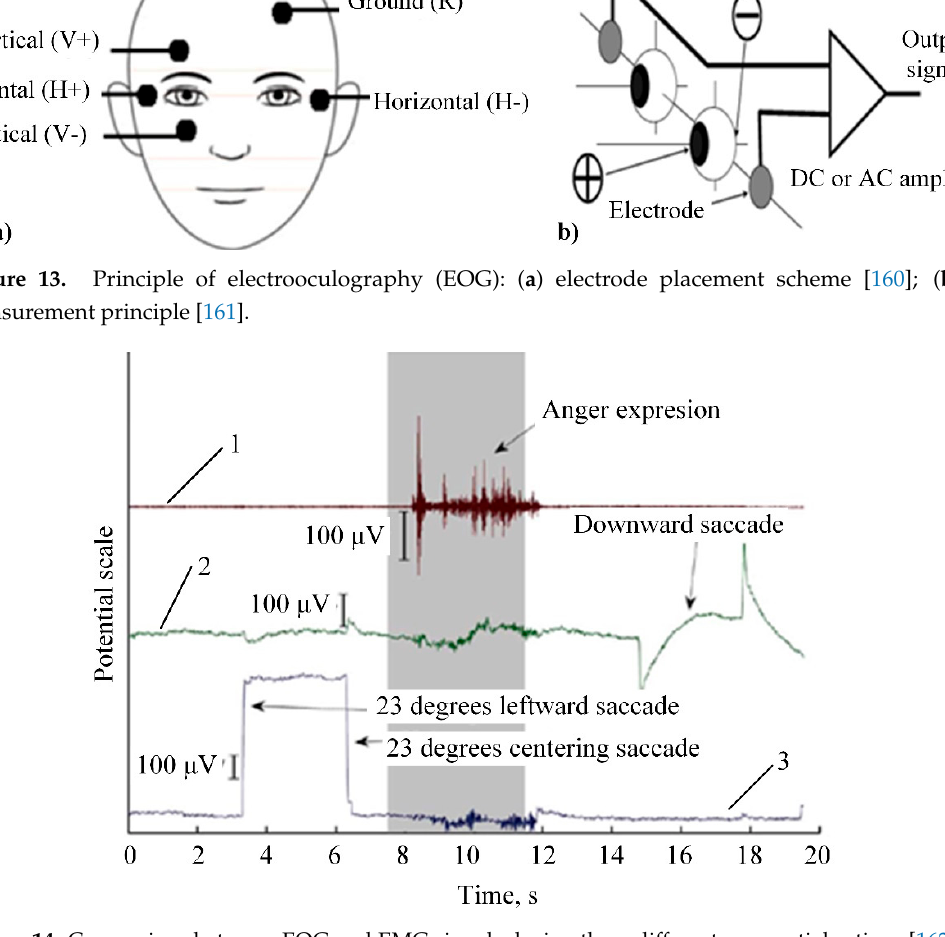
Figure 14. Comparison between EOG and EMG signals during three different, sequential actions [162]: 1—Corrugator supercilii EMG; 2—vertical EOG; 3—horizontal EOG. EOG can be applied using contact and non-contact measurement techniques.